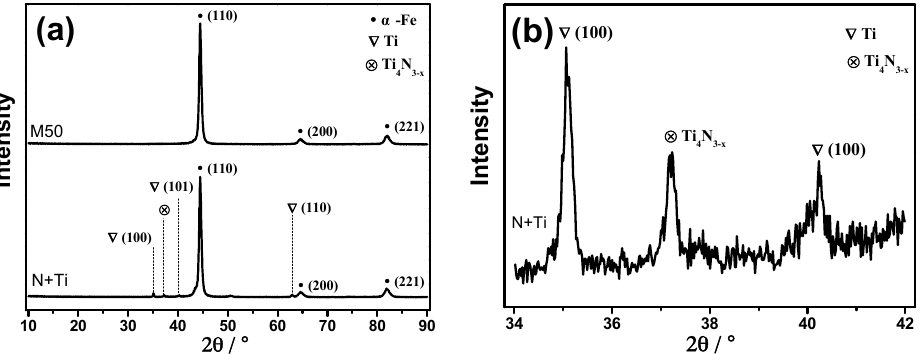
Figure 4. XRD spectra of pre- and post-implantation M50. ( a ) Normal scan; ( b ) Fine scan in the range of 34–42°.